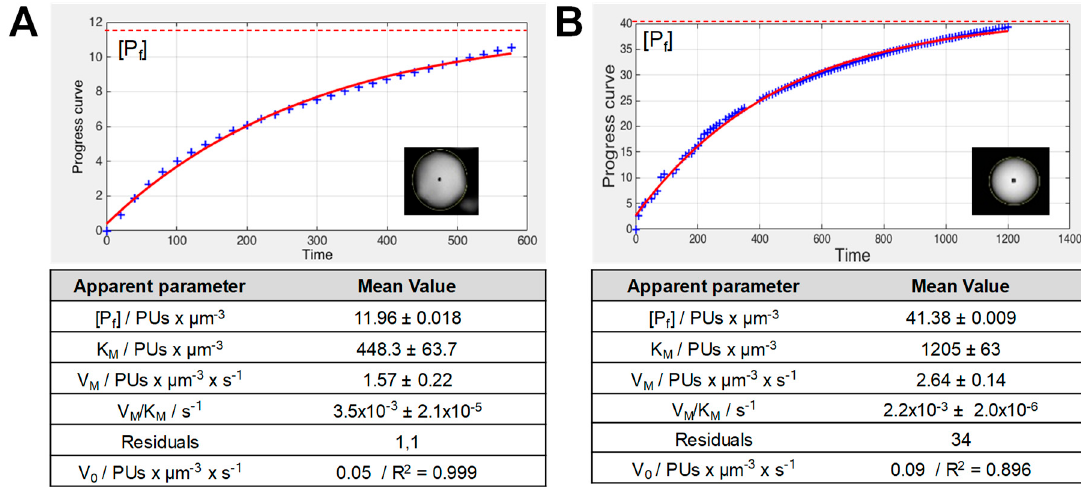
Figure 2. PCAT fitting of time-course data acquired from single-particle analysis shown in Figure 1A ( A ) and in Figure 1B ( B ). The fitting done through an analytical approximation gives rise to the following apparent kinetic parameters (bottom tables): [P f ] = maximum product